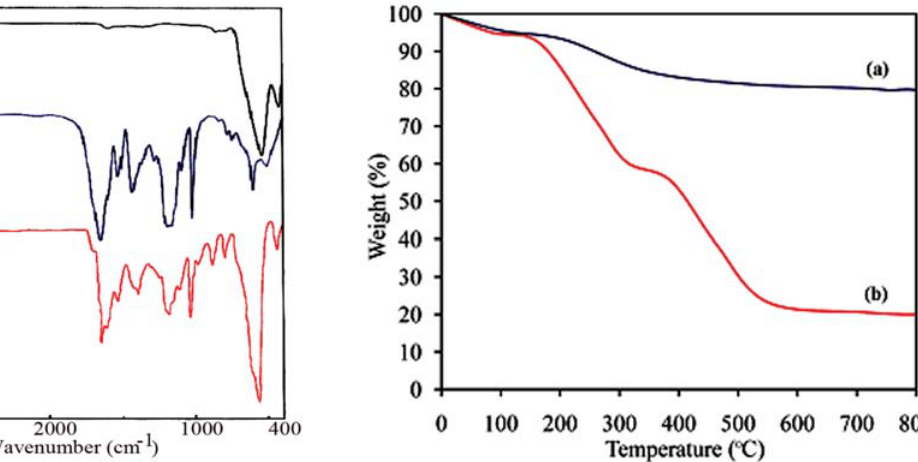
Figure 1. FT-IR spectra of Fe poly(AMPS- co -AA) @ Fe